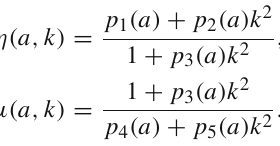
Table 2 The layout of the binned parametrizations